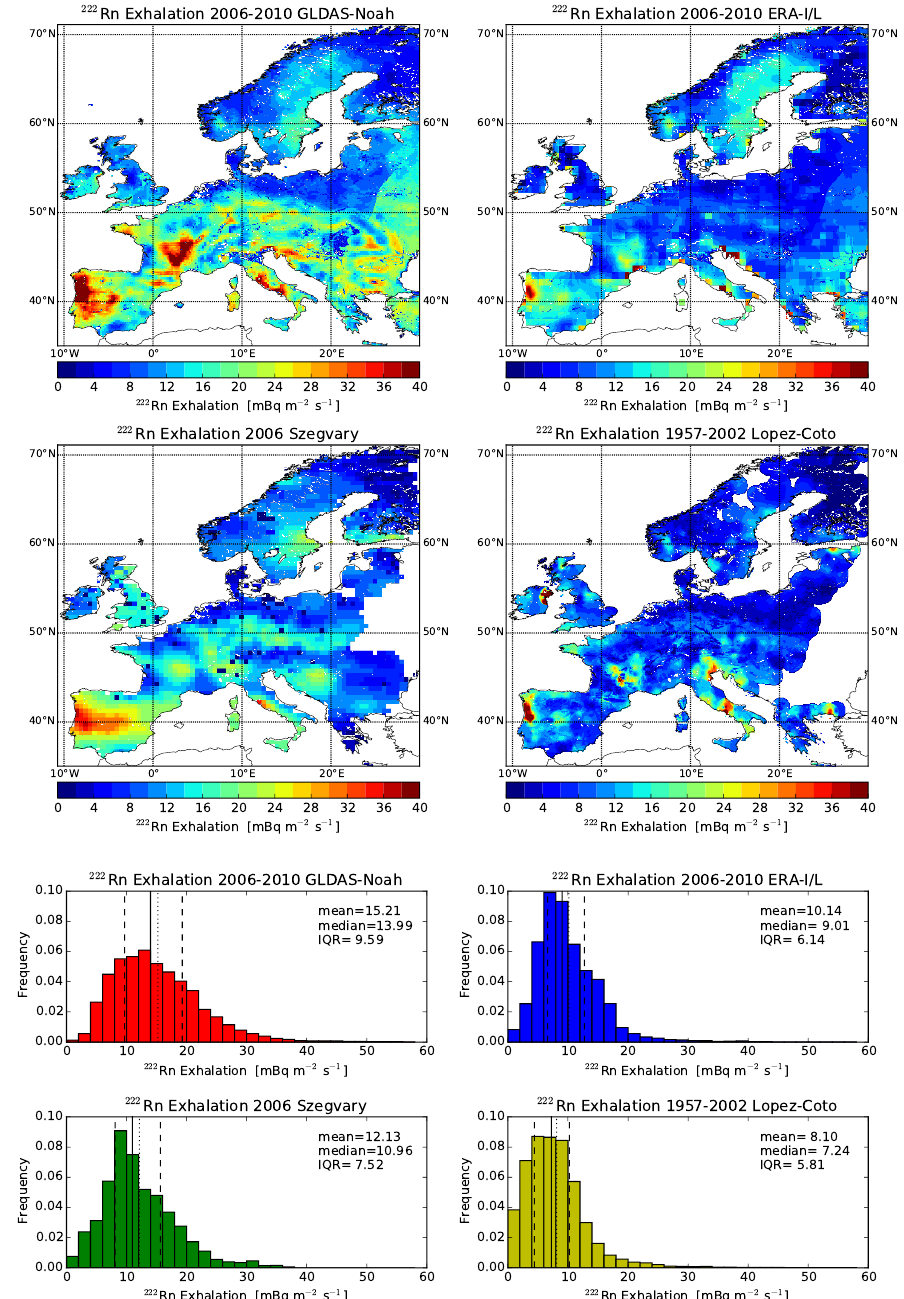
Figure 4. Annual mean 222 Rn exhalation rates for 2006-2010 from this study in comparison with published maps (Szegvary et al., 2009; López-Coto et al., 2013). The upper four panels show the geographical distributions, while the lower four panels display the normalized frequency distributions of annual means from all pixels of the four